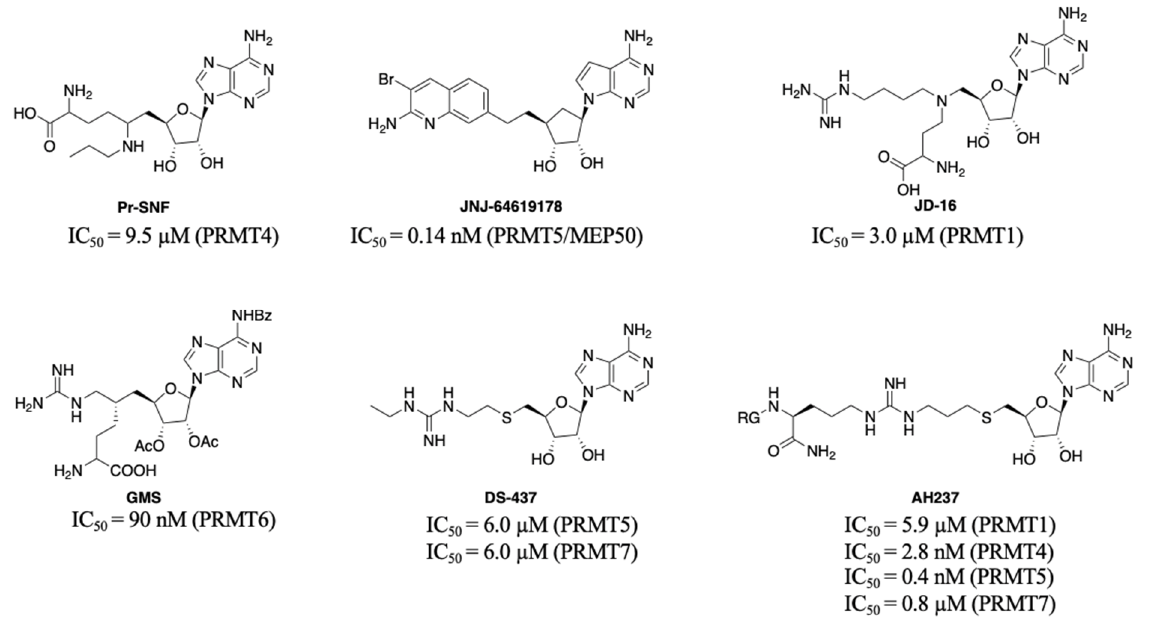
Figure 1. Representative structures of bisubstrate inhibitors of